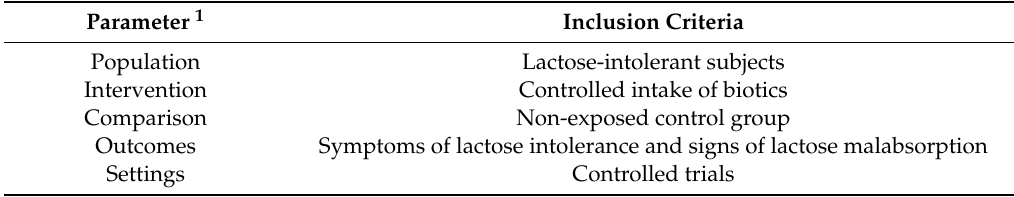
Table 1. Population, Intervention, Comparison, Outcome, Settings (PICOS) criteria [29] for the inclusion of studies of the e ff ects of prebiotics and probiotics on lactose